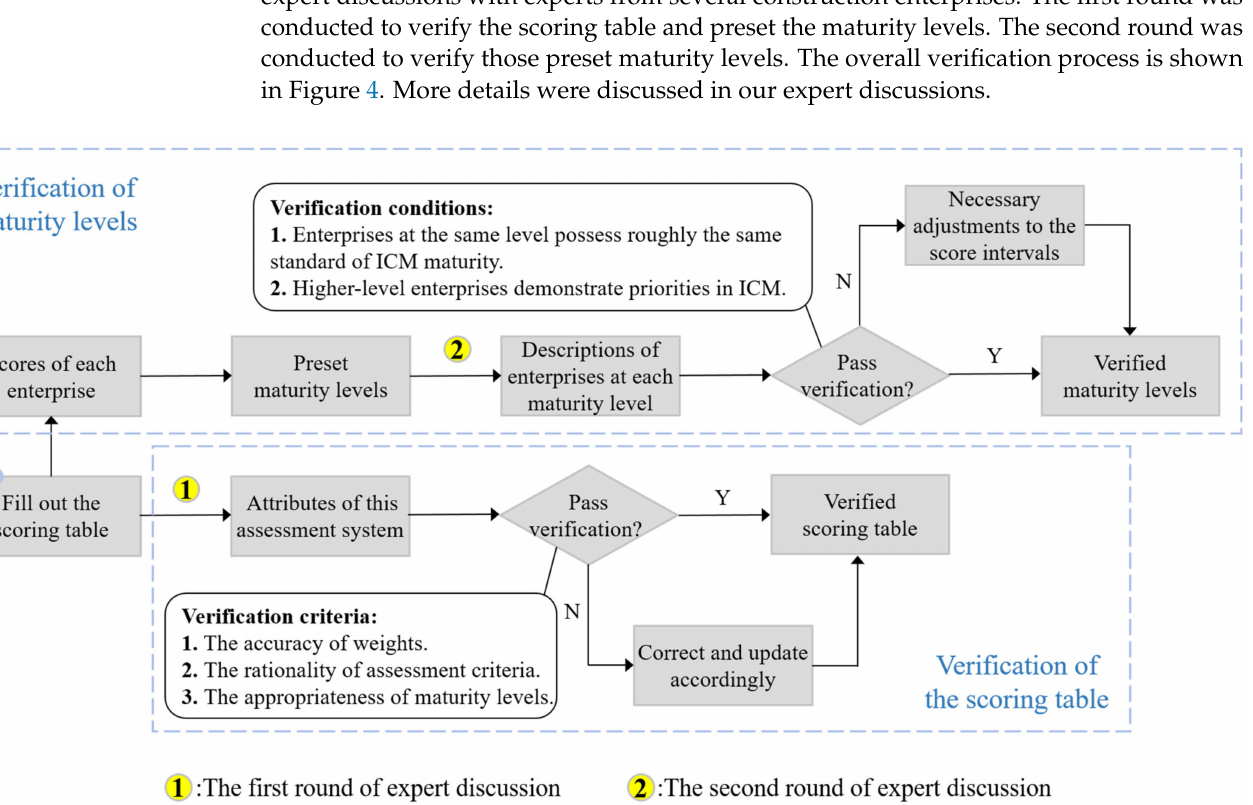
Figure 4. The overall verification